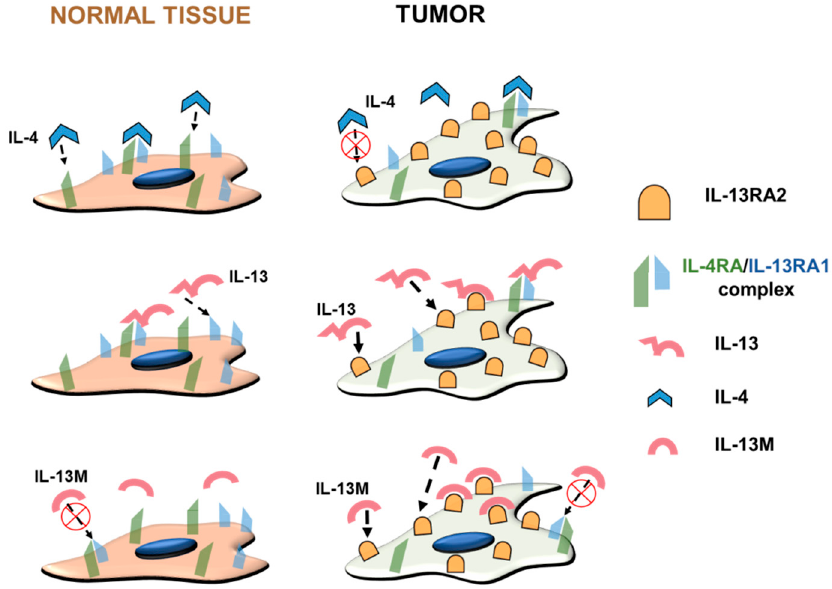
Figure 2. A schematic of the IL-13 receptor system. Normal and tumor cells express IL-4RA/IL-13RA1. IL-4RA/IL-13RA1 have IL-4RA (represented in green) and IL-13RA1 (represented in blue) subunits. IL-4 first binds to IL-4RA, then to the IL-13RA1 to form an IL-4RA/IL-13RA1 complex. IL-13 first binds to IL-13RA1, then to IL-4A to form an IL-4RA/IL-13RA1 complex in normal tissue. On the other hand, IL-13RA2 is expressed by tumor cells. IL-4 binds to IL-4RA/IL-13RA1, but not to IL-13RA2 (represented by a red encircled cross). IL-13 binds to both IL-4RA/IL-13RA1 and IL-13RA2. IL-13 binds more readily to IL-13RA2 compared to IL-4RA/IL-13RA1. By introducing mutation in the IL-13 ligand to produce IL-13M, the ligand binds mostly only to the IL-13RA2, and not to IL-4RA/IL-13RA1 complex (represented by a red encircled cross).